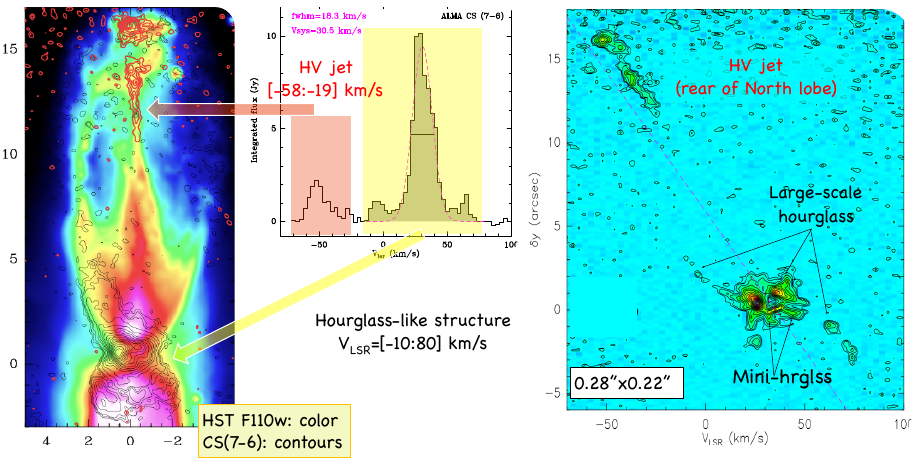
Figure 4. Overview of the CS(7 − 6) emission maps of OH231.8 + 4.2 showing the integrated intensity map, atop the HST /F110W image ( left ), the one-dimensional spectral profile ( middle ), and the axial PV diagram ( right ). Different nebular components are indicated (namely, the large-hourglass, the HV-lobes, and the mini-hourglass). See text for details.